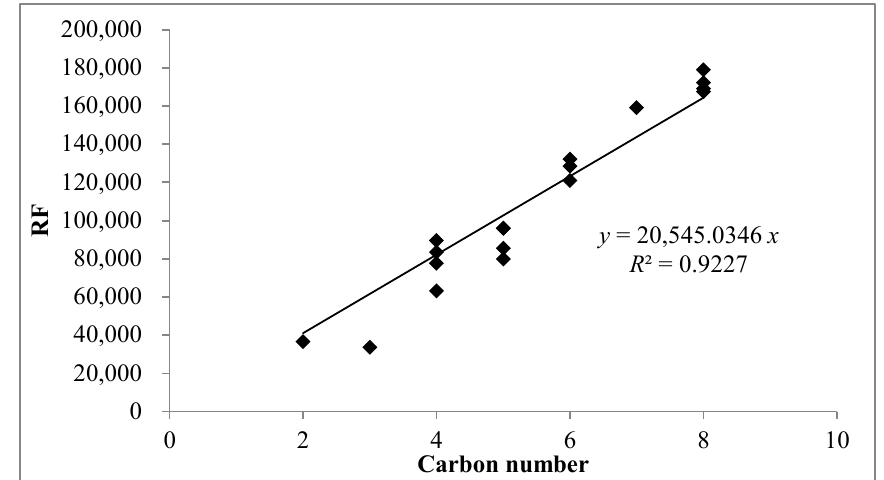
Figure 2. Predictive equation based on carbon number approach for quantification of non-target (reference)